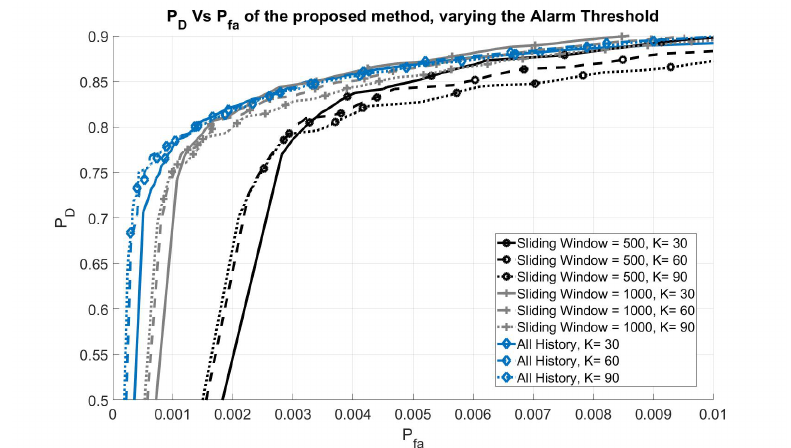
Figure 6. Performance of the proposed method (Scenario 1) varying the alarm